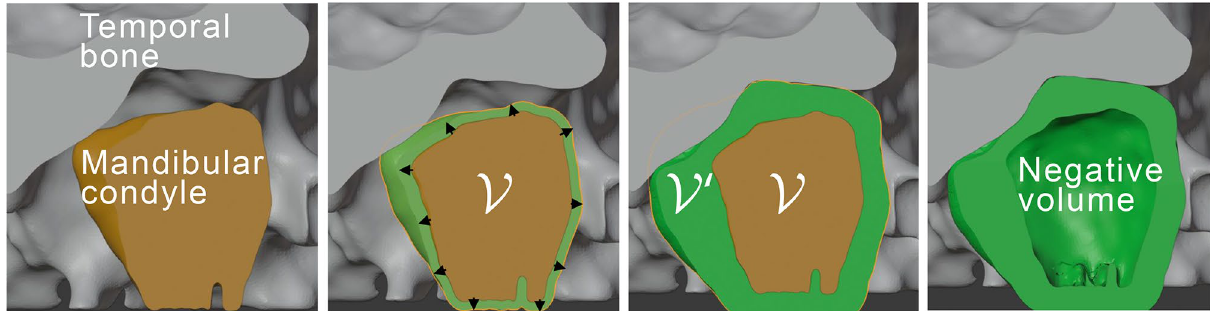
Figure 3. Proposed negative volume inflation routine seen in TMJ cross-section (frontal view): (1) segmented MC bone is a starting point (mesh V ), (2) surface of MC spreads along the normals, (3) inflated MC reaches bounding volume defined by TB model (mesh V ′ ), (4) MC removal and clipping of the neck of the mandible generates the negative volume. Figure created with Incscape v.1.1, https:// inksc ape.